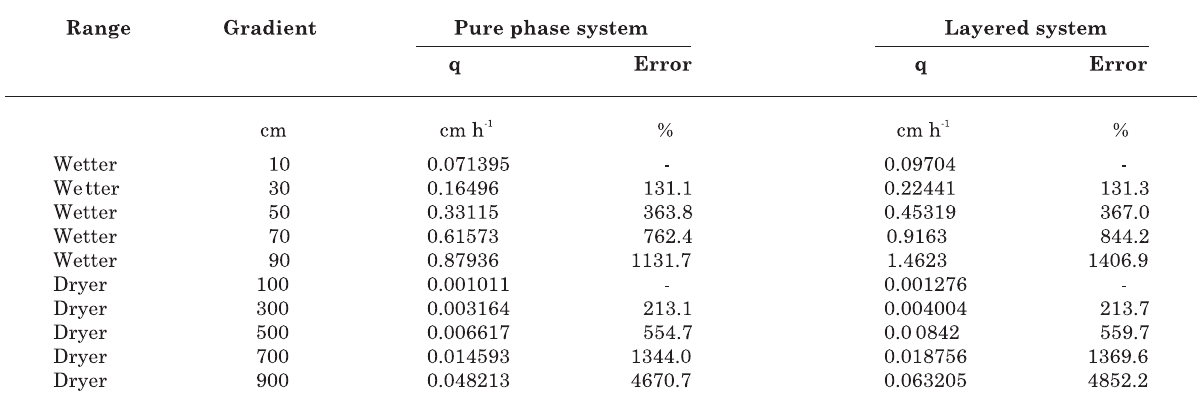
Table 3. Estimated hydraulic flux error with variation in boundary conditions assuming the lowest gradient (-50 to -60 cm and -500 to -600 cm) as baseline